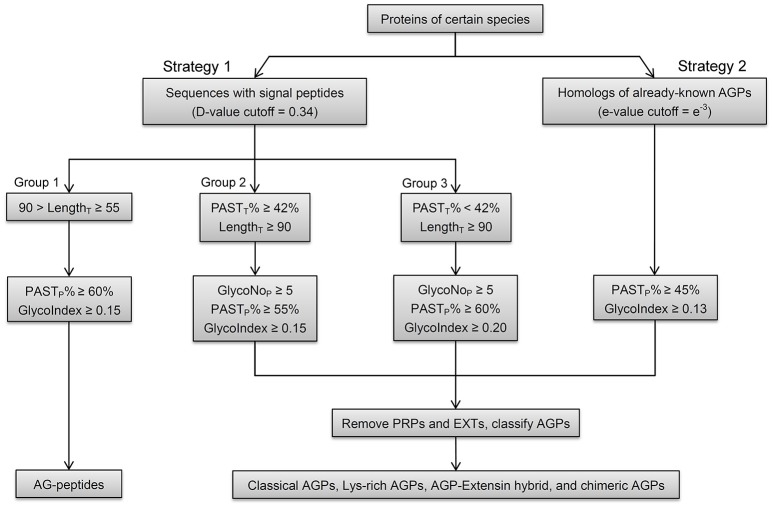
Schematic workflow of the integrated strategy in identifying AGPs. Strategy 1 (signal peptide filtration), which includes three groups, is mainly for the identifications of AGPs with relatively high PASTT% in given length ranges. The operation of Group 1 identifies AG-peptides. Group 2 and 3 can identify classical AGPs, Lys-rich classical AGPs, AGP-extensin hybrids, and non-classical AGPs. Strategy 2 (BLAST searches) is mainly for the identifications of chimeric AGPs (FLAs, PAGs, and XYLPs) and any other AGPs with high homology to known AGPs. The PASTP% and GlycoIndex are used to get PAST-rich AGP-like sequences with glycomodules throughout. The GlycoNoP is also defined as five for both Group 2 and 3. The other types of HRGPs (mainly EXTs and PRPs) are removed and the remaining AGP candidates are classified into classical AGPs, Lys-rich classical AGPs, AGP-extensin hybrid, AG-peptides, chimeric AGPs (FLA, PAG, and XYLP), and other chimeric AGPs (non-classical AGPs are deemed as members belong to other types of chimeric AGPs).